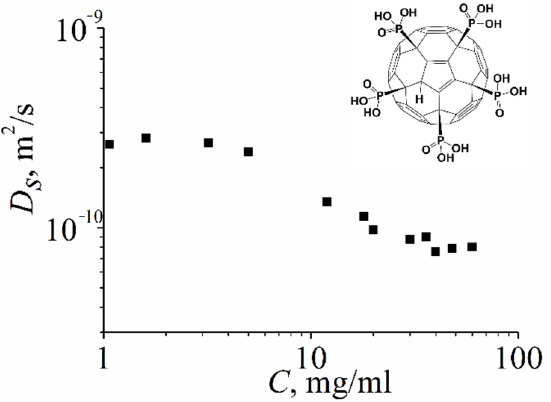
Figure 5. The concentration dependence of self-diffusion coefficients of compound VIII in D 2 O measured on 31 P nuclei.